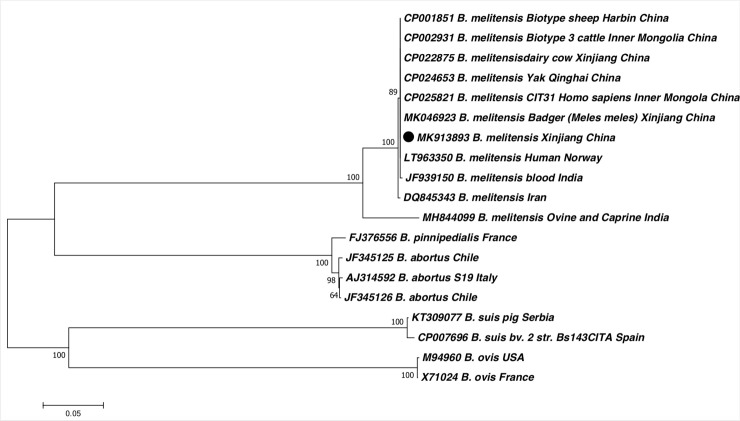
Phylogenetic tree of the IS711 concatenated sequence of Brucella melitensis (⦁) isolated from aborted cow or sheep fetuses in this study and reference sequences from Brucella melitensis retrieved from the GenBank database.The tree was constructed according to the neighbor-joining (NJ; 500 bootstrap replicates) and maximum–likelihood (ML, 1000 bootstrap replicates) analyses using MEGA7. The scale bar represents the inferred substitutions per nucleotide site.